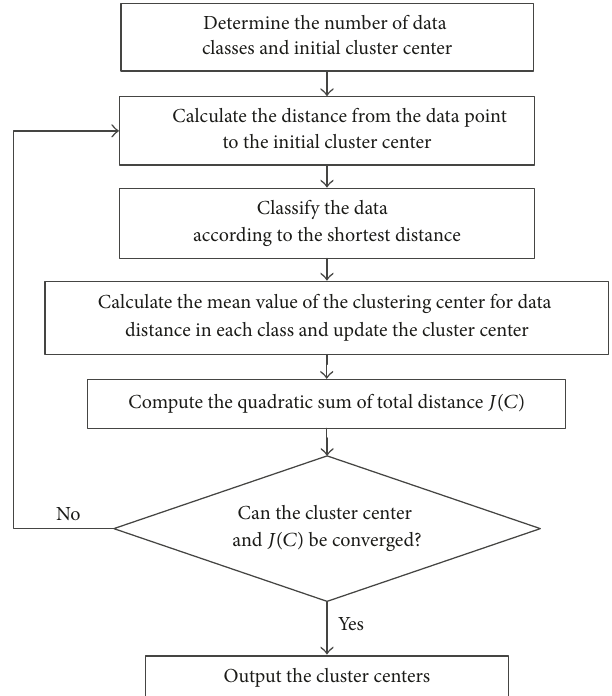
Figure 1: Flow chart of the 𝐾 -means clustering